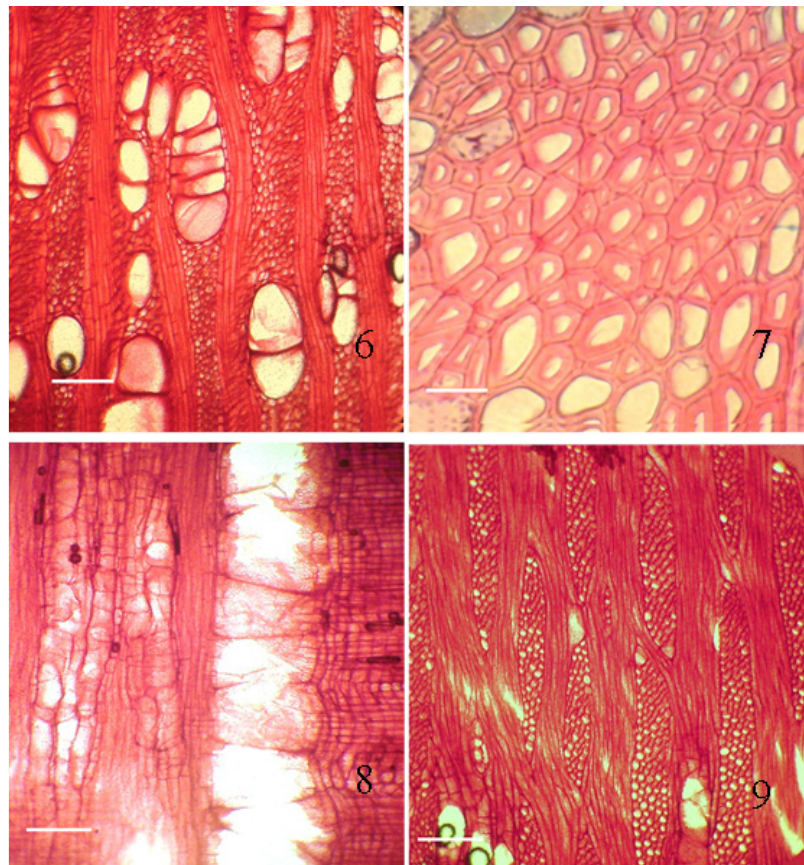
Fig. 6-9. Microscopic sections of Morus nigra ; 6-Transverse section; 7-Wall thickness of fibers; 8- Radial section; 9-Tangential section; Scale bars = 100